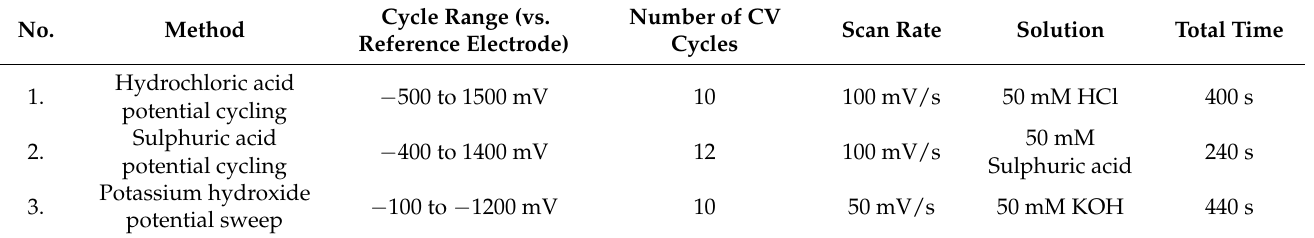
Table 1. Parameters of electrochemical treatment